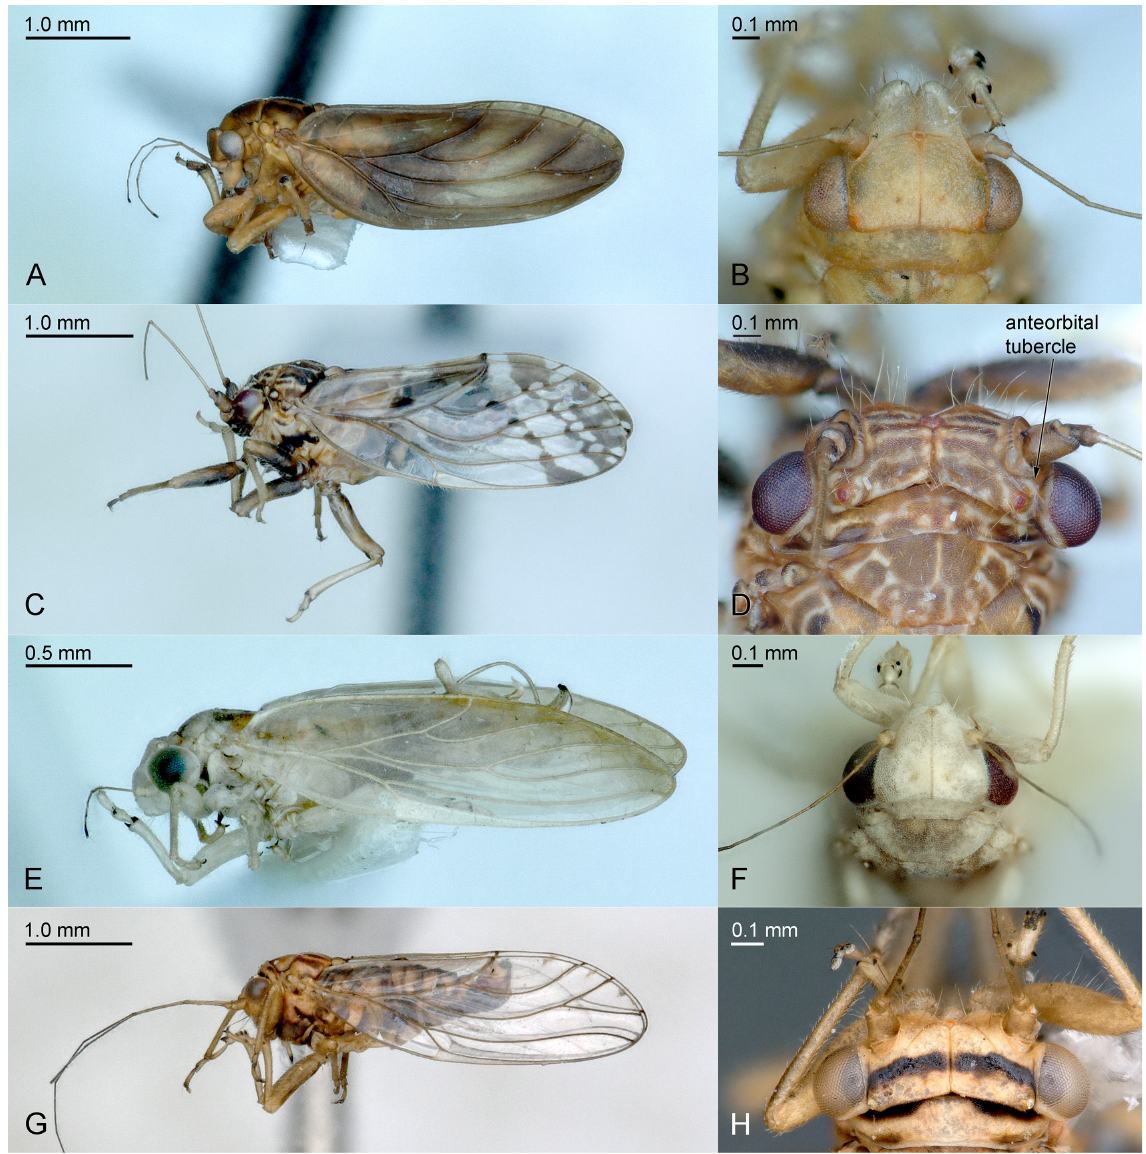
Fig. 8. Platycoryphinae subfam. nov. A–B . Allophorina sp. C–D . Limbopsylla nata Brown &